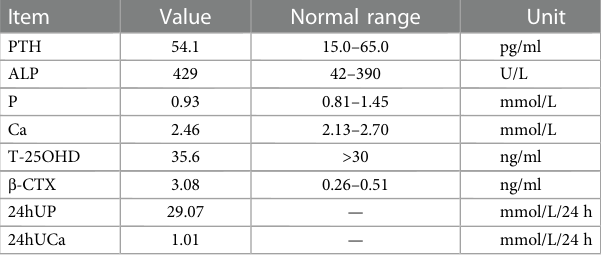
TABLE 3 Laboratory tests regarding calcium and